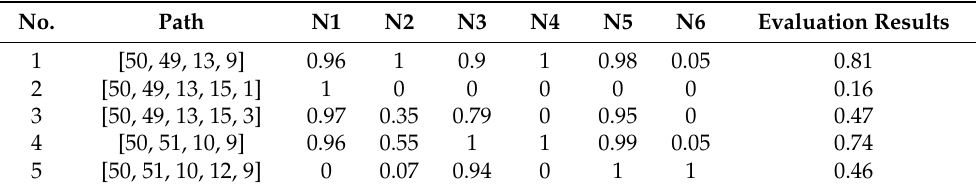
Table 3. Distribution network route and evaluation (20 kV).